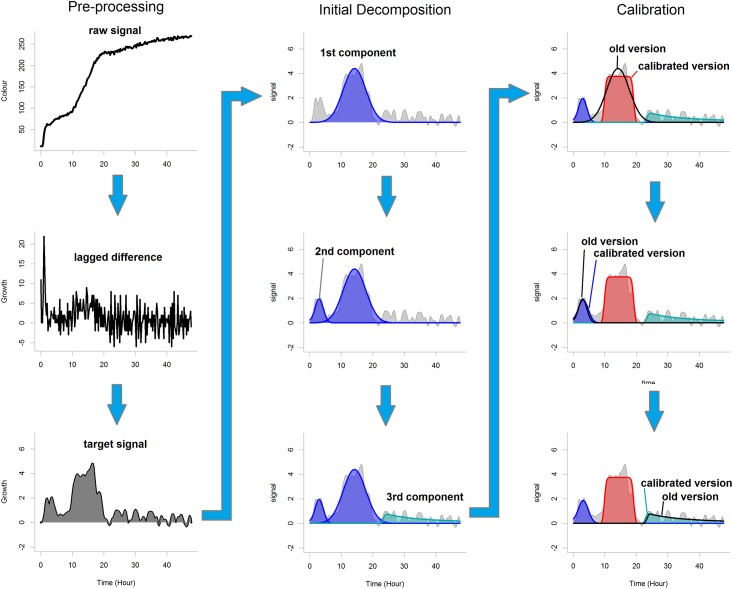
Decomposition of a Biolog signal.During the pre-processing raw signal is converted to the target signal. During the initial decomposition three components (putative cycles of metabolic activity) are revealed: two Gaussian sequences and a slope sequence. During the calibration these components are refined: the first component changes its type to a brick sequence, the second and the third are slightly adjusted.